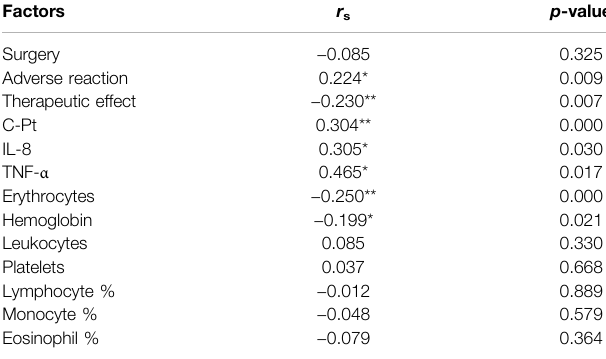
TABLE 3 | Spearman correlation analysis on CRF and impact factors.